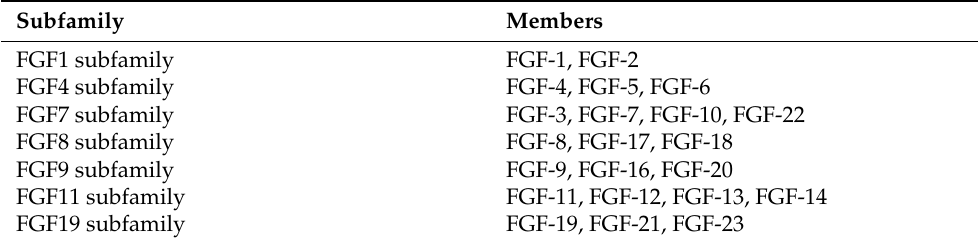
Table 1. FGF members and their distribution in